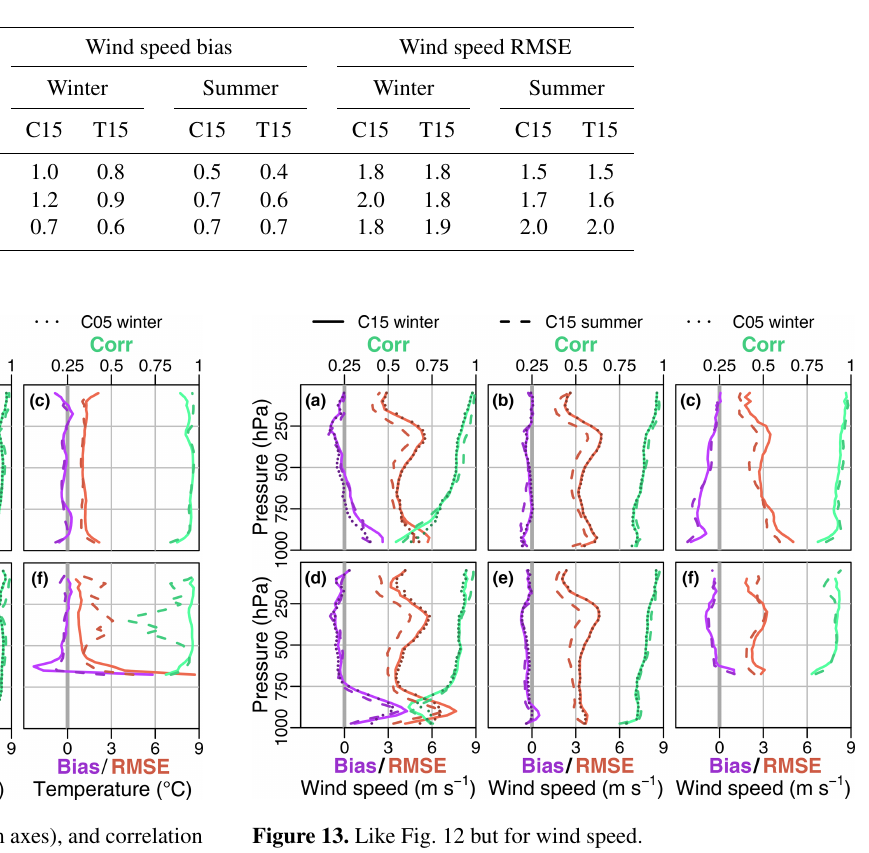
Table 7. As Table 6 but for wind speed.